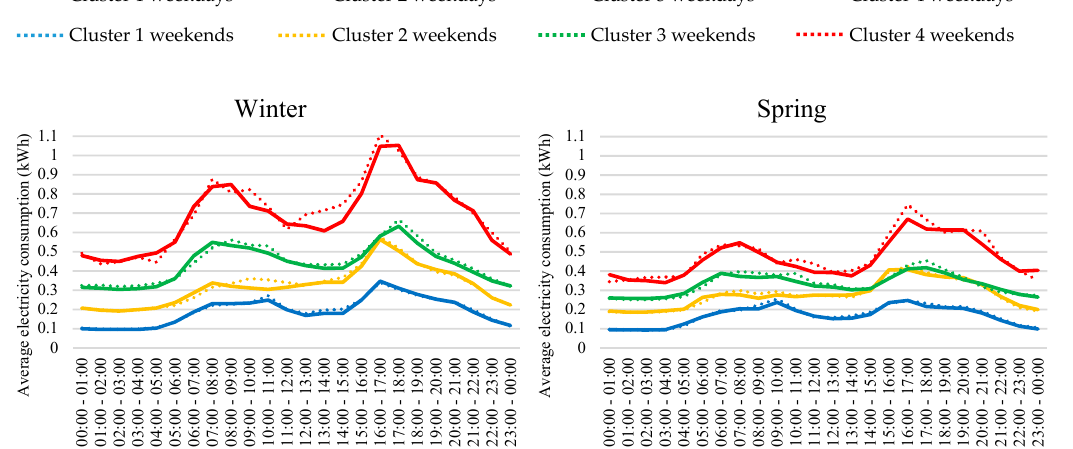
Table 2. Annual average base consumption (kWh), average consumption (kWh), and average peak consumption (kWh) of the four clusters. Cluster (K)